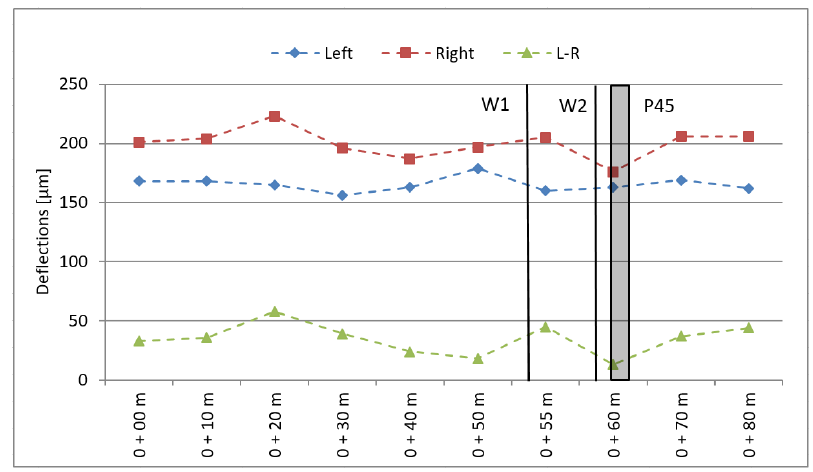
Figure 3. Pavement testing—dynamic deflections (W1, W2—strain gauge load cell sensors; P45— piezoelectric sensors).